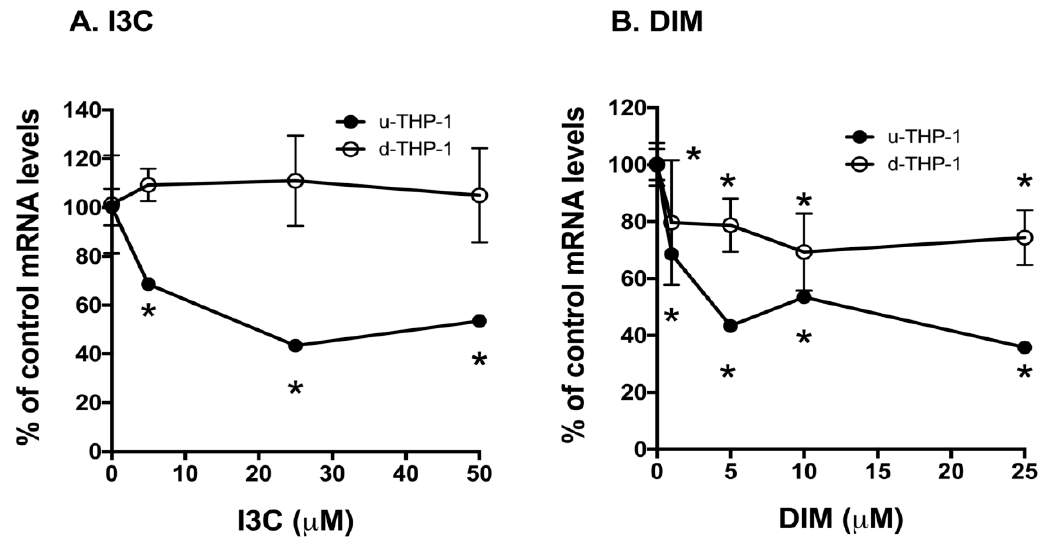
Figure 2. Effects of I3C, DIM on CD84 mRNA levels in THP-1 cells . THP-1 cells were differentiated using PMA as described in Materials and Methods. U-THP-1 and d-THP-1 cells were treated with or without I3C or DIM as described in Materials and Methods. After treatment with the compounds, cells were exposed to LPS for 2 h, total RNA isolated and CD84 mRNA expression determined using RT-PCR. The treatment results were normalized to LPS-induced IL-1 β mRNA level in the absence of compounds and expressed as % control ( n = 3, mean ± SD). ( A ) Effect of I3C; ( B ) Effect of DIM. * indicates significant difference from vehicle control at p ≤ 0.05.